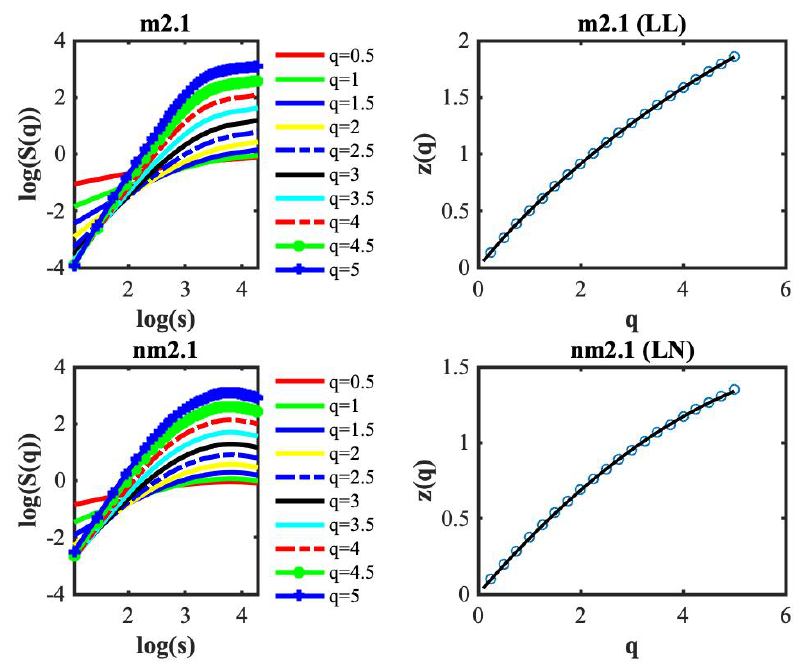
Figure A3. Linear regression of log ( S ( q )) versus log ( s ) . For clarity reasons, the order of moments in the range [ 0.5,5 ] with a step of 0.5 are displayed. The actual calculations were carried out for moments in the range [0.25, 5] with a step of 0.25. The slope of each line corresponds to the value of the scaling exponent of the structure function, z ( q ) . Two cases (m2.1 and nm2.1) are provided. The title (LL) for m2.1 means Log Levy, and (LN) for nm2.1 means Log Normal, see discussion below.